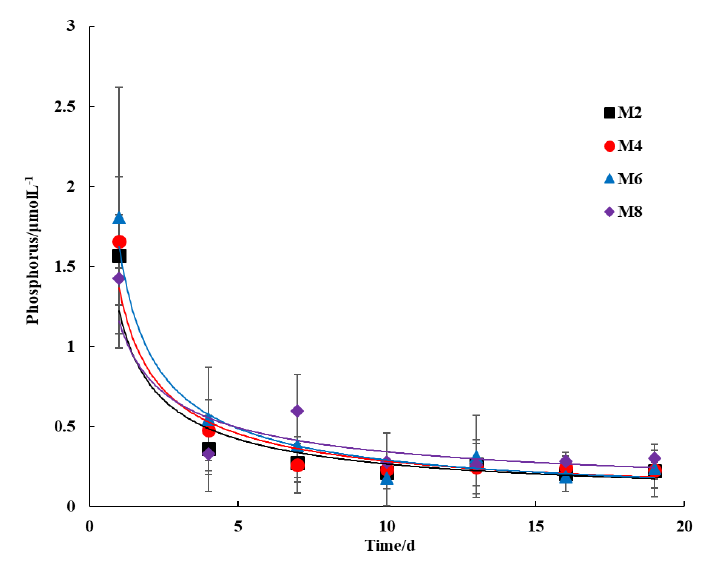
Figure 3. Phosphorus dissolution (M2: y = 1.2205 x − 0.662 , R 2 = 0.8905; M4: y = 1.364 x − 0.683 , R 2 = 0.9122; M6: y = 1.6231 x − 0.748 , R 2 = 0.8931; M8: y = 1.1557 x − 0.53 , R 2 = 0.8975).